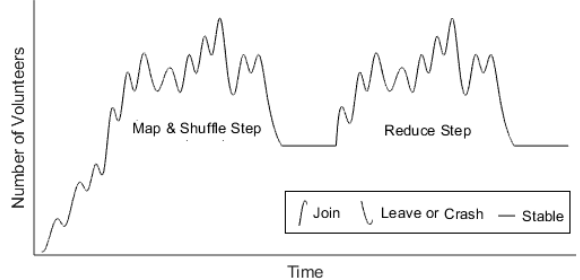
Figure 1. The random churn patterns.